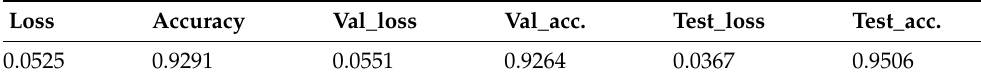
Table 3. Neural network evaluation showing the loss (MSE) and accuracy (Binary) for the final network for the training, validation, and test datasets. Loss